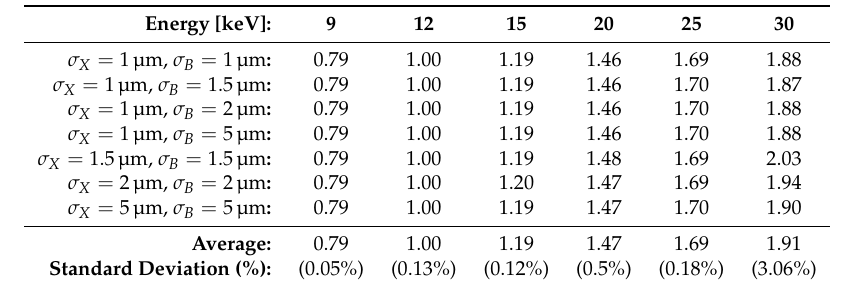
Table A2. Diffraction efficiency, relative to 12keV, of all simulated data sets based on RADDOSE-3D [9] dose maps that did not account for either Compton scattering or PE escape. The data show minimal variation with beam and crystal